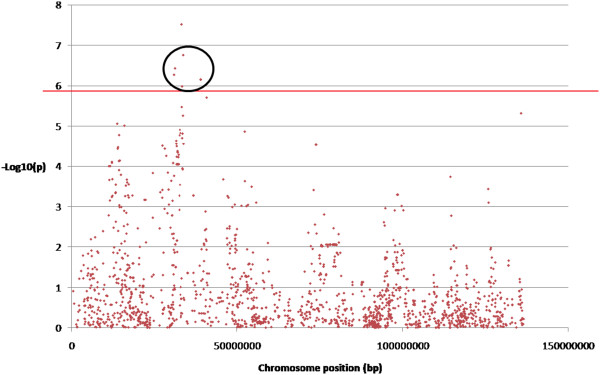
Graphical microarray outputs from chromosome 7 in the SLLW breed. Legend: Graphical microarray outputs from chromosome 7 in the SLLW breed. Each of the dots represents a SNP plotted against its chromosome position (bp) and significance value (-log10(p)). The circled SNPs represent SNPs discovered within the following genes: TINAG, DST and GLO1.